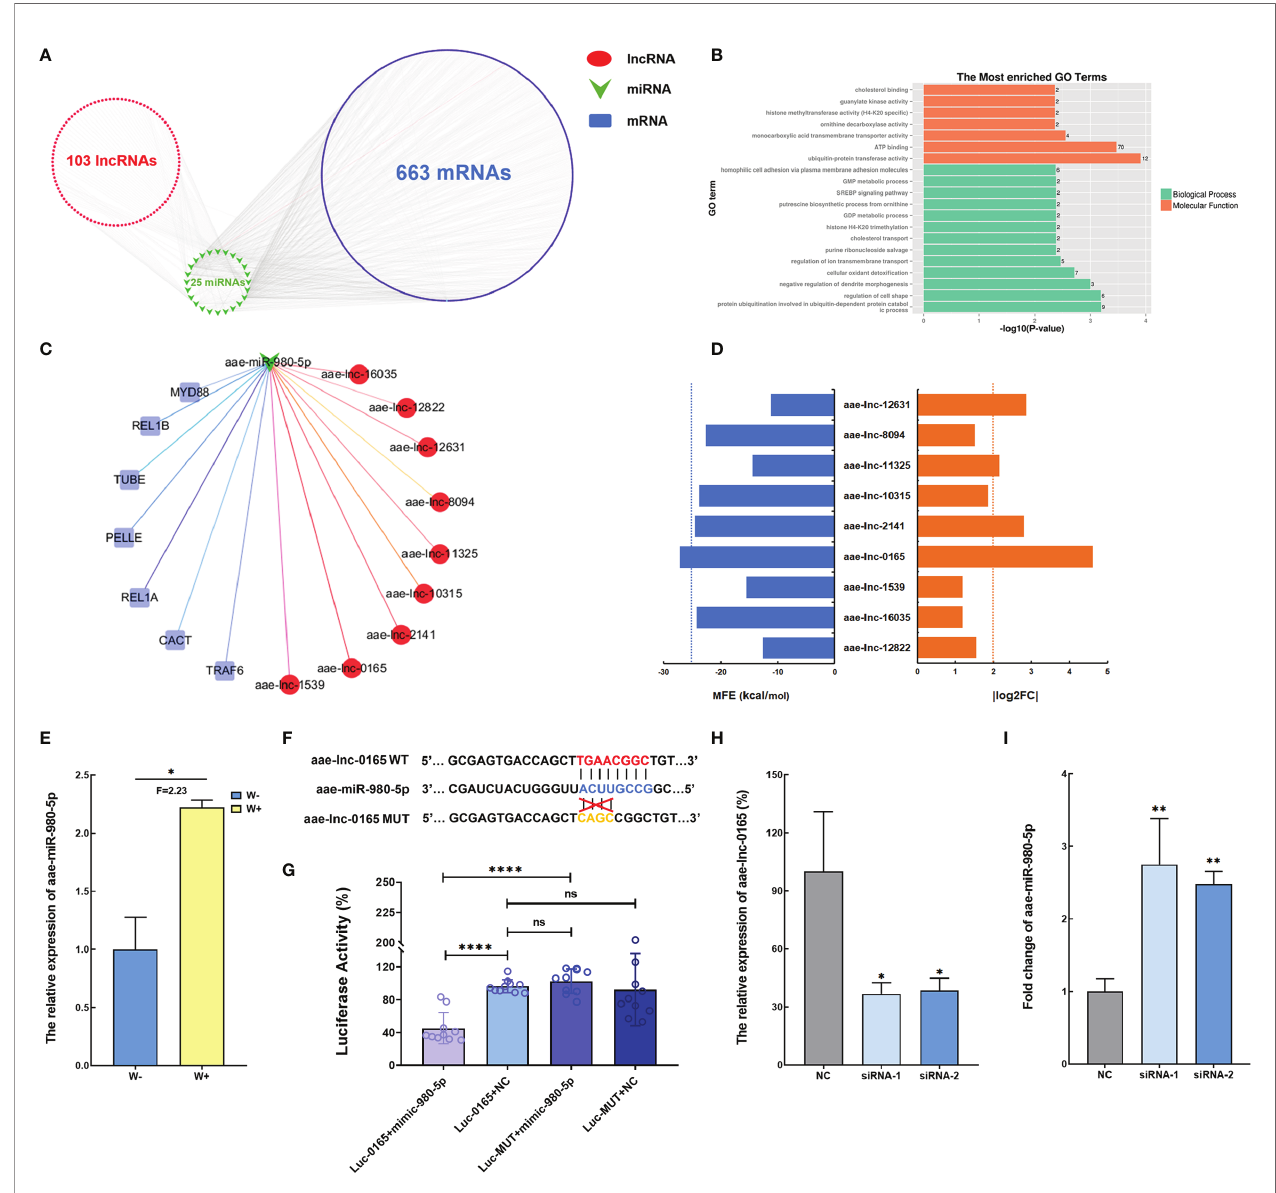
FIGURE 3 | Wolbachia reduces aae-lnc-0165 to induce aae-miR-980-5p (A) The ceRNA network of DE lncRNA-miRNA-mRNA. (B) GO enrichment analyses of target genes for DE lncRNAs. (C) The ceRNA network based on the Toll pathway regulator genes and DE lncRNAs. Each red circle represents a lncRNA; the green arrow represents miRNAs, while the blue rectangular represents immune genes. (D) The MFE value and absolute value of log2 (fold change) for DE lncRNAs associated with the Toll pathway. The blue dotted line indicates MFE threshold of -25kcal/mol and the orange dotted line indicates that the cutoff value forlog 2 ( fold change ) is 2. (E) The relative expression level of aae-miR-980-5p in W-Aag2 (W+) and Aag2 (W-) cells. (F) Schematic diagram of the target binding sites between aae-miR-980-5p and aae- lnc-0165 predicted by RNAhybrid software. (G) Dual luciferase reporter assay indicates the binding relationship between aae-lnc-0165 and aae-miR-980-5p. Luc-0165 +mimic-980-5p represents the 293T cells co-transfected with psi-CHECK-2-WT-0165 and aae-miR-980-5p mimic; Luc-0165+NC indicates the 293T cells co-transfected with psi-CHECK-2-WT-0165 and mimic control; Luc-MUT+mimic-980-5p represents the 293T cells co-transfected with psi-CHECK-2-MUT-0165 and aae-miR-980-5p mimic; Luc-MUT+NC indicates the 293T cells co-transfected with psi-CHECK-2-MUT-0165 and mimic control; n=10. (H) The relative expression of aae-lnc-0165 at 48-hour post transfection. (I) The expression of aae-miR-980-5p at 72-hour post transfection; **** P < 0.0001; ** P < 0.01; * P < 0.05; ns means no signi fi cant difference. F means fold